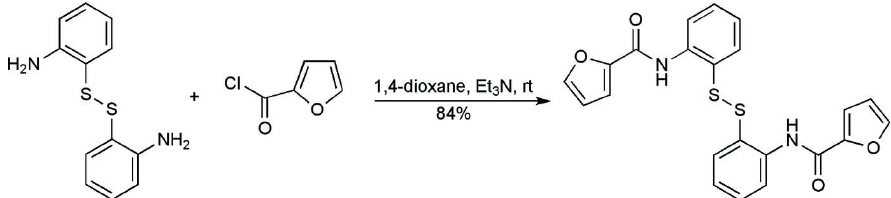
Figure 3 The formation of the title